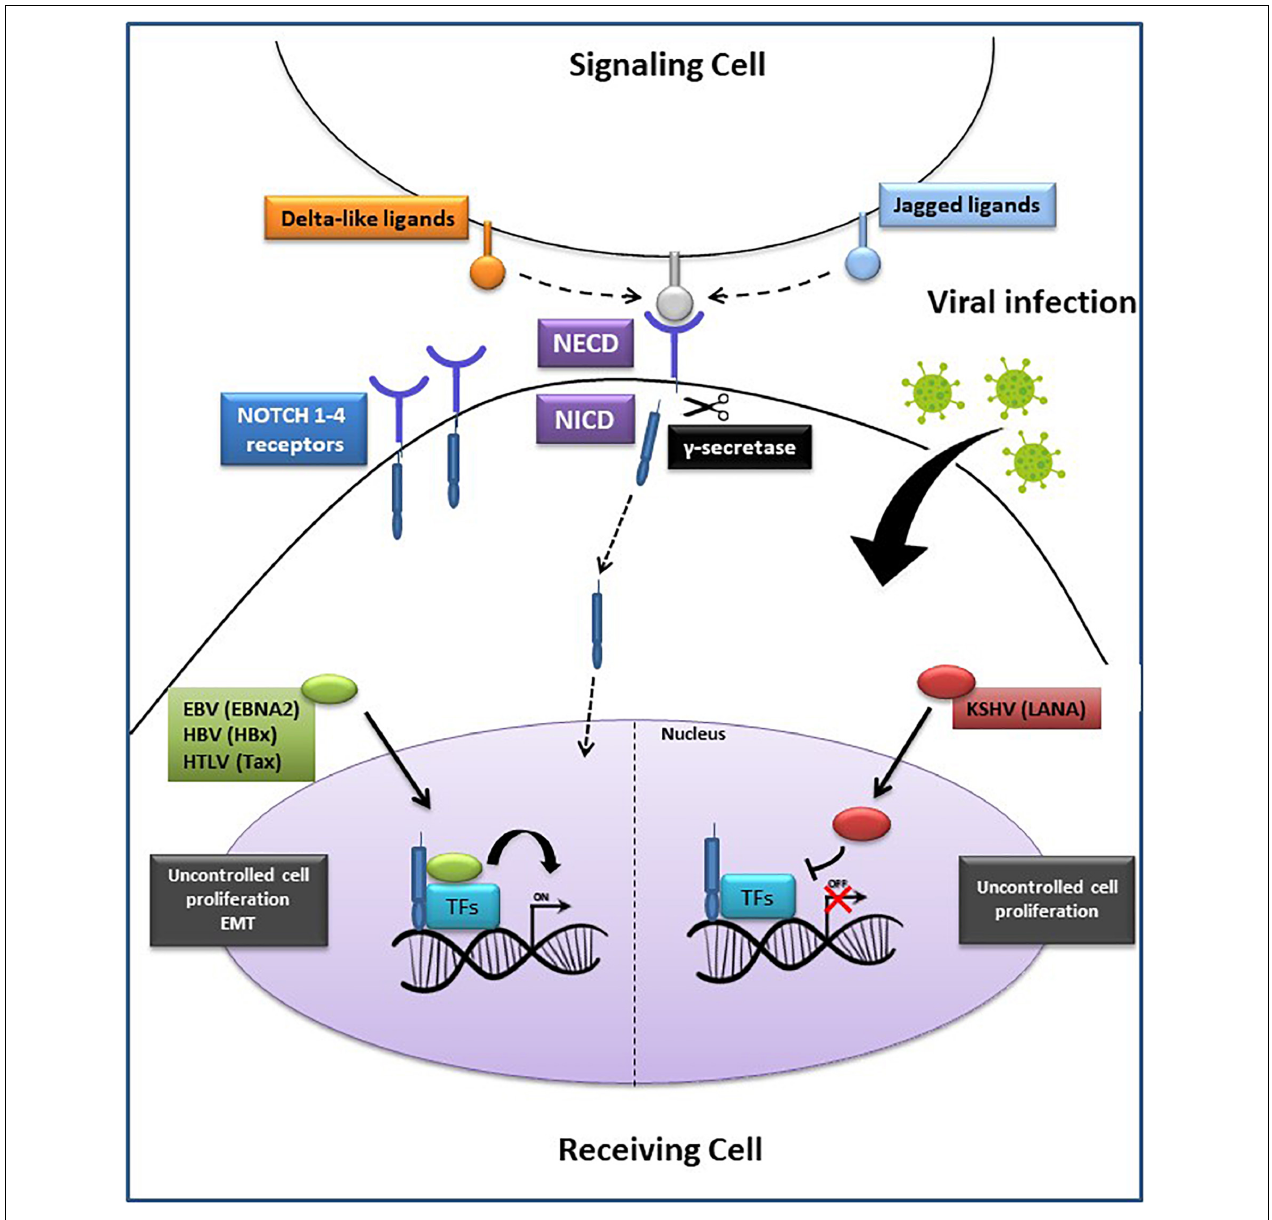
FIGURE 2 | Oncogenic viruses exploit the Notch signaling pathway. Notch ligands (Delta-like or Jagged) on the signaling cell bind to Notch 1–4 receptors on the receiving cell, generating the Notch extracellular domain (NECD) and the Notch intracellular domain (NICD). Subsequently, the proteolytic cleavage of NECD by γ -secretase, generates NICD translocation into the nucleus where it binds with the transcription factors (TFs): recombining binding protein Jk (RBP–J κ ), cAMP response element-binding protein (CREB), forming an active complex that regulates the transcription of Notch target genes. On the (Left side) : EBNA2, HBx and Tax proteins encoded by EBV, HBV, and HTLV, respectively, promote cell proliferation or epithelial-mesenchymal transition (EMT) through a direct interaction with the transcription complex, leading to tumorigenesis. On the (Right side) : LANA protein, encoded by KSHV, prevents the activation of the transcription complex, resulting in an accumulation of NICD and increased cancer cells proliferation. EBV, Epstein Barr Virus; HBV, Hepatitis B Virus; HTLV-1, Human T Lymphocyte Virus-1; KSHV, Kaposi’s Sarcoma-associated